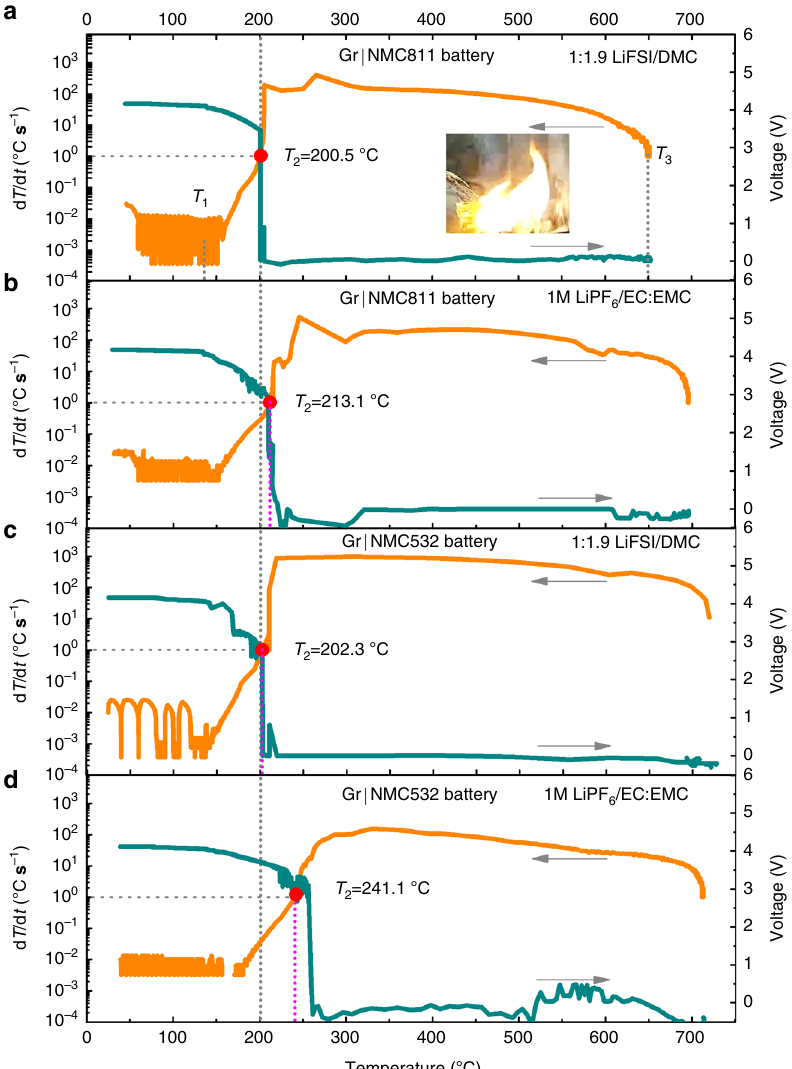
Fig. 2 Comparison of thermal runaway features of Gr|NMC batteries with concentrated LiFSI/DMC and conventional 1 M LiPF 6 /EC:EMC electrolytes. a Gr|NMC811 battery with the concentrated LiFSI/DMC electrolyte. The inset shows the combustibility of battery in the lateral heating test. b Gr|NMC811 battery with the conventional 1 M electrolyte. c Gr|NMC532 battery with the concentrated LiFSI/DMC electrolyte. d Gr|NMC532 battery with the conventional 1 M electrolyte. d T /d t - T curves of Gr|NMC811 and Gr|NMC532 batteries based on the ARC test, were plotted in logarithmic coordinates. T 1 was de fi ned as the onset temperature of self-heating, which results from the onset of the chain reactions inside the battery, leads to a spontaneous and continuous rise in temperature if the battery is kept under a poor heat dissipation condition or an almost adiabatic condition. T 2 was de fi ned as the trigger temperature of thermal runaway preset at the d T /d t of 1 °C s − 1 . T 3 was de fi ned as the maximum temperature during the thermal runaway, which is a key parameter in the evaluation of the destructiveness of thermal